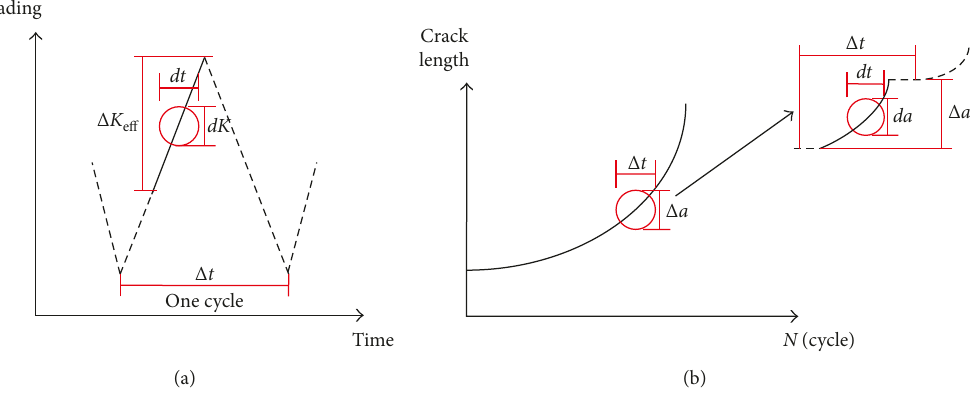
Figure 1: Schematic illustration of the state-based fatigue crack